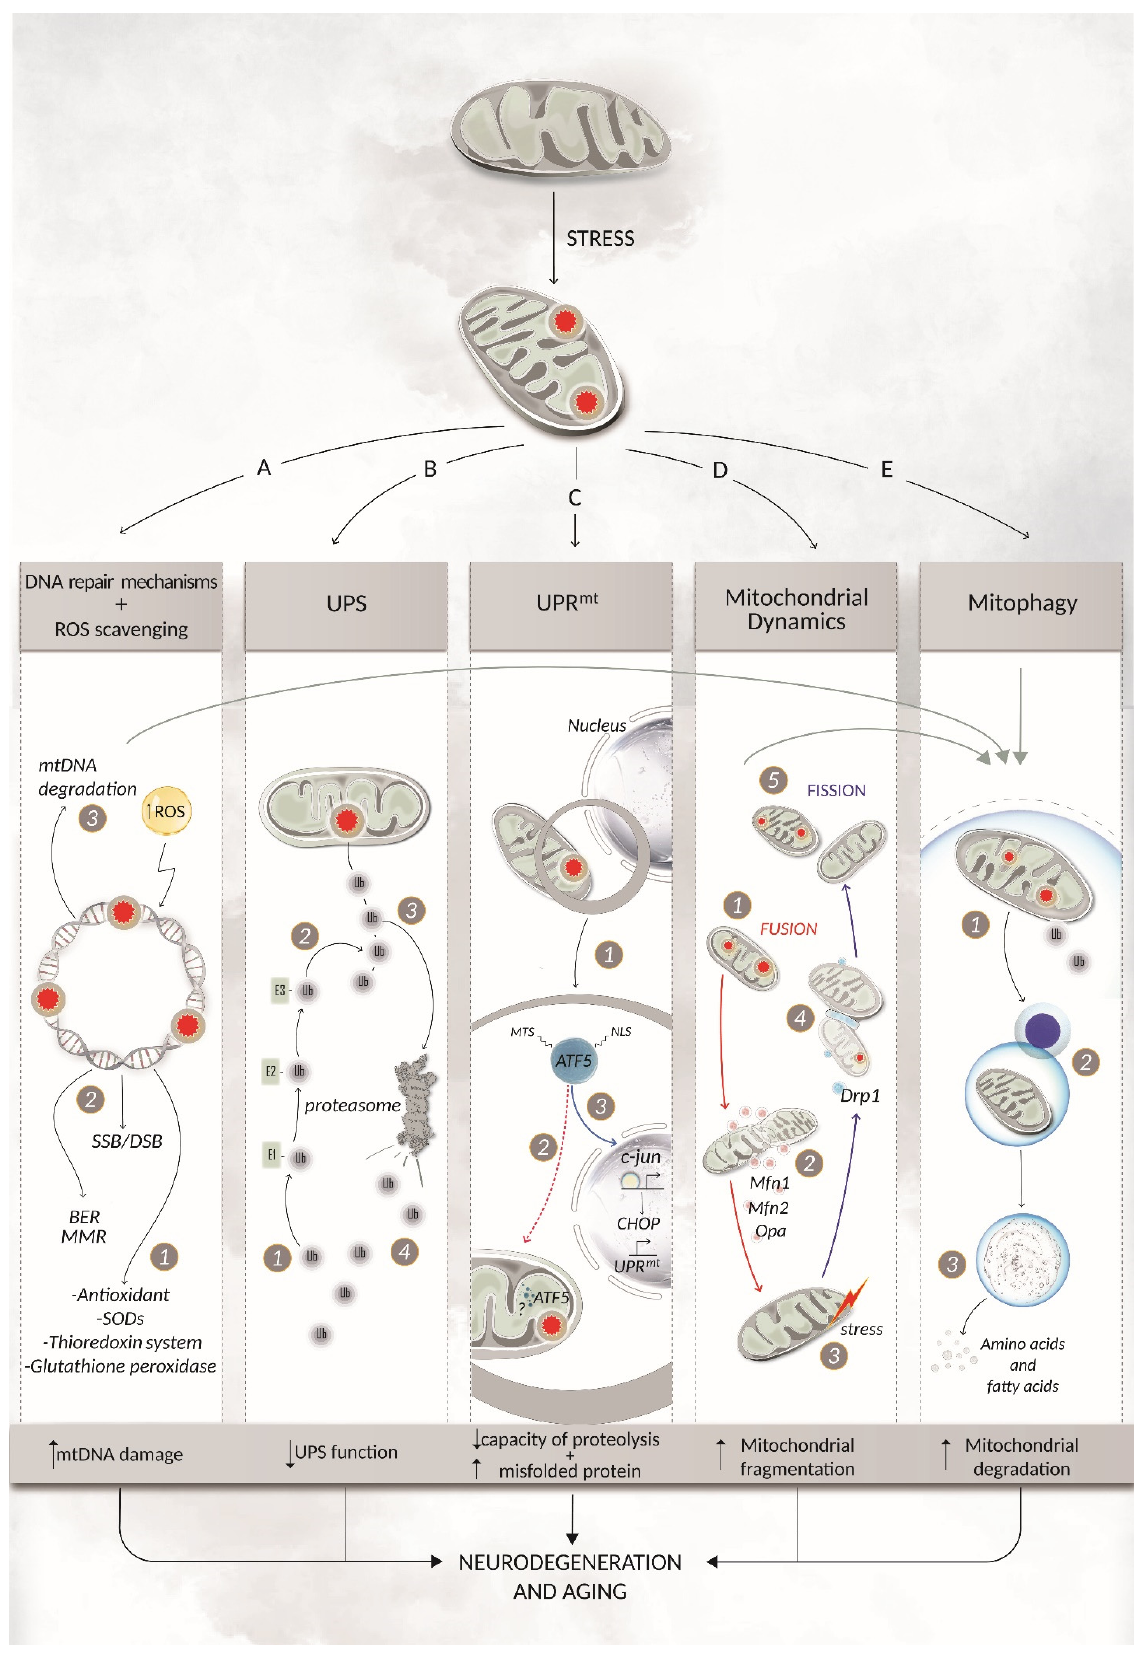
Figure 1. Mitochondrial quality control: regulating mitochondrial turnover and homeostatic mtDNA repair mechanisms and ROS scavenging (A). Various mechanisms can be activated to either